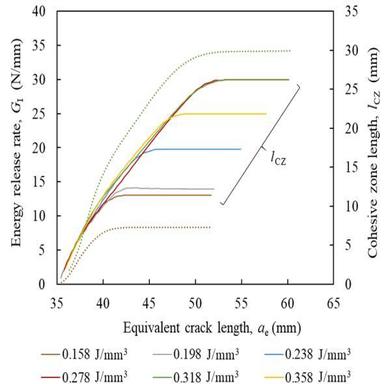
Evolution of lCZ as a function of ae of SLS test specimens depending on EDV. Dotted-line refers to R-curves.